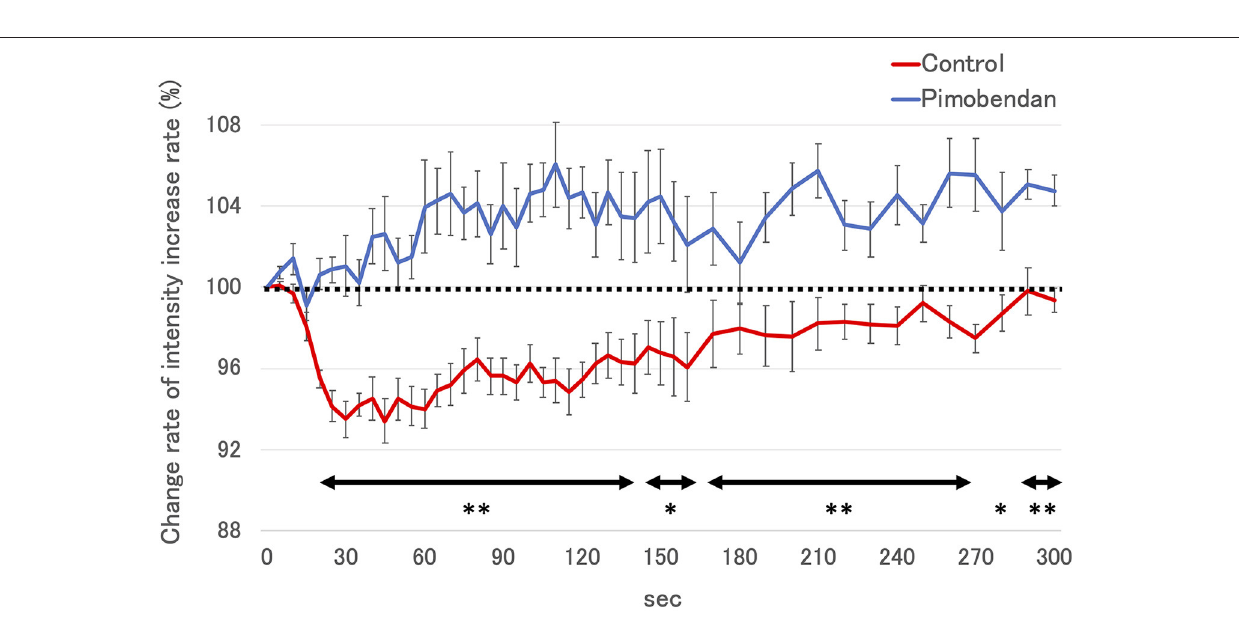
FIGURE 3 | The change rate of intensity increase rate in control group and the pimobendan group in contrast-enhanced ultrasonography (CEUS). The intensity increase rate at each measurement time point after Sonazoid ® administration before initiating RVP (baseline) was defined as 100% (dotted line). These values are shown as the mean ± standard error. *; P < 0.05 vs. control, **; P < 0.01 vs.